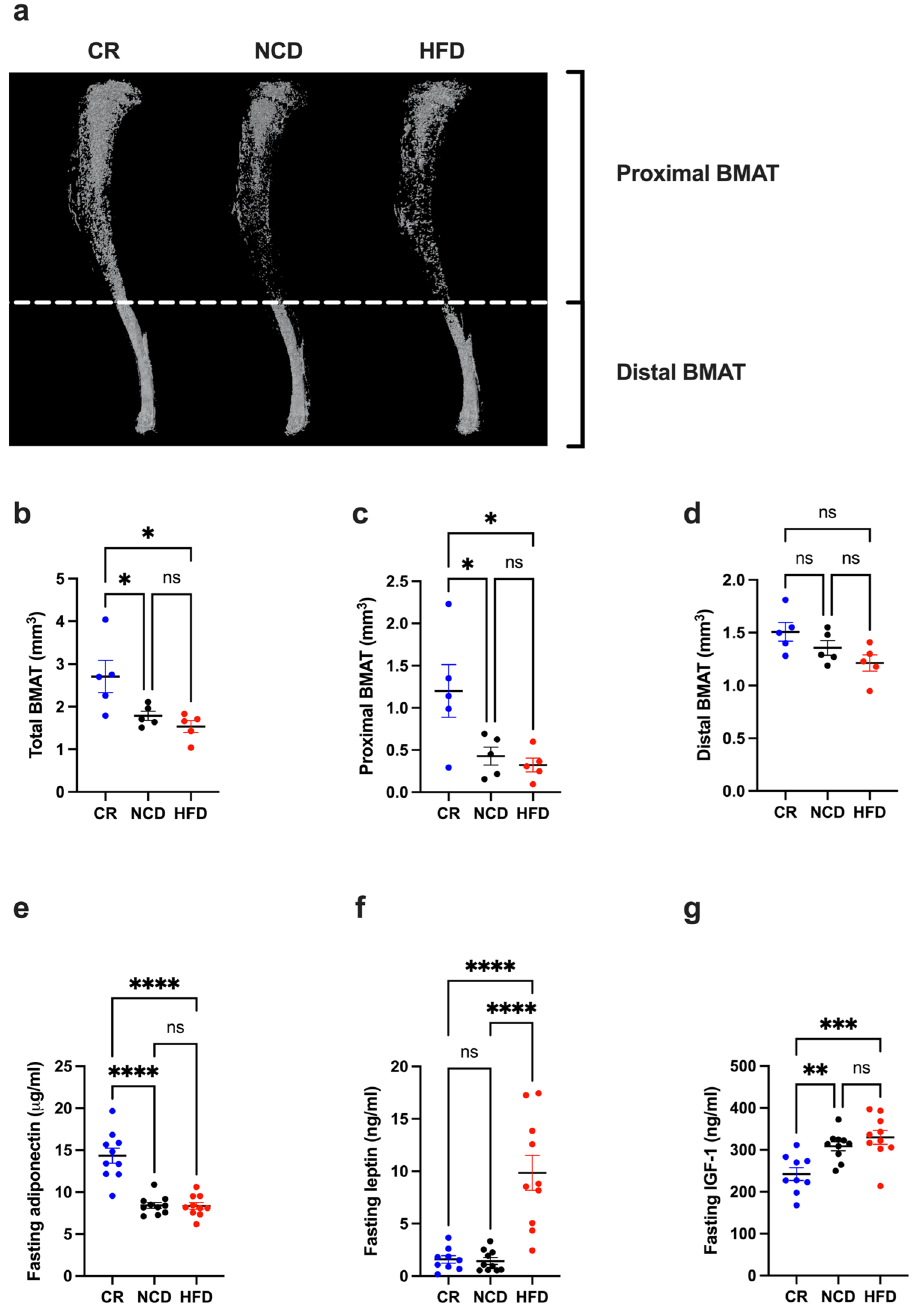
Figure 2. CR promotes proximal BM adiposity and an increase in serum adiponectin levels. ( a ) Representative images of osmium tetroxide stained tibias, ( b ) Total BMAT, ( c ) Proximal BMAT, ( d ) Distal BMAT, ( e ) Fasting serum adiponectin levels, ( f ) Fasting serum leptin levels, ( g ) Fasting serum IGF-1 levels. Error bars SEM, ( a – d ) n = 5/group, ( e – g ) n = 10/group, ns p > 0.05, *p < 0.05, **p < 0.01, ***p < 0.001, ****p < 0.0001, Ordinary one-way ANOVA with Tukey’s multiple comparisons